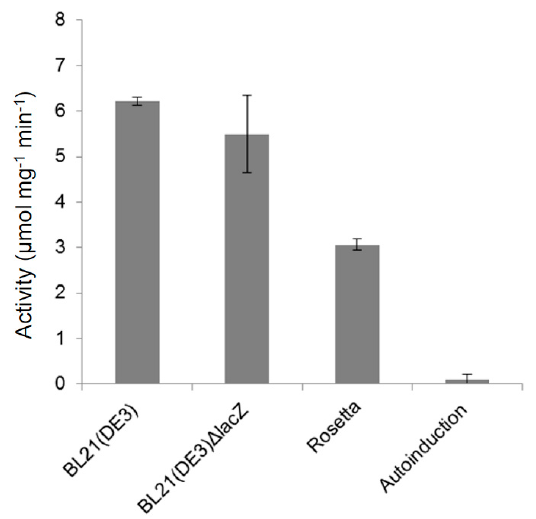
Figure 3. β -NAHA activity in µmol per min per mg of total protein in the lysates of three different Escherichia coli ( E. coli ) strains harboring Ph Nah20A grown in lysogeny broth (LB) induced by isopropyl thio- β - D -galactoside (IPTG) or in the auto-induction medium ZYM-5052 [56] (30 h). E. coli BL21(DE3) transformants carrying the full-length Ph Nah20A gene in an pURI3TEV expression vector were used in the auto-induction experiment. Values are given as the average of three independent experiments and the standard deviation (SD) is shown.